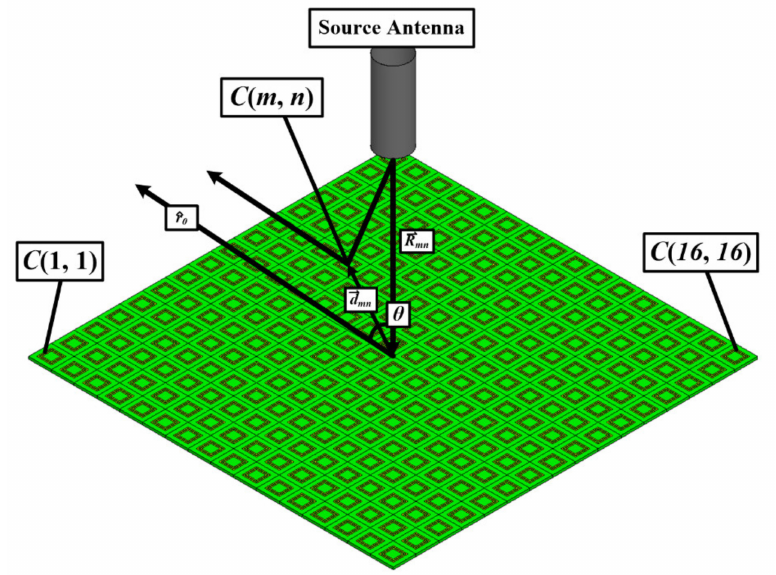
Figure 1. Operation principle of a flat-panel metasurface reflectarray